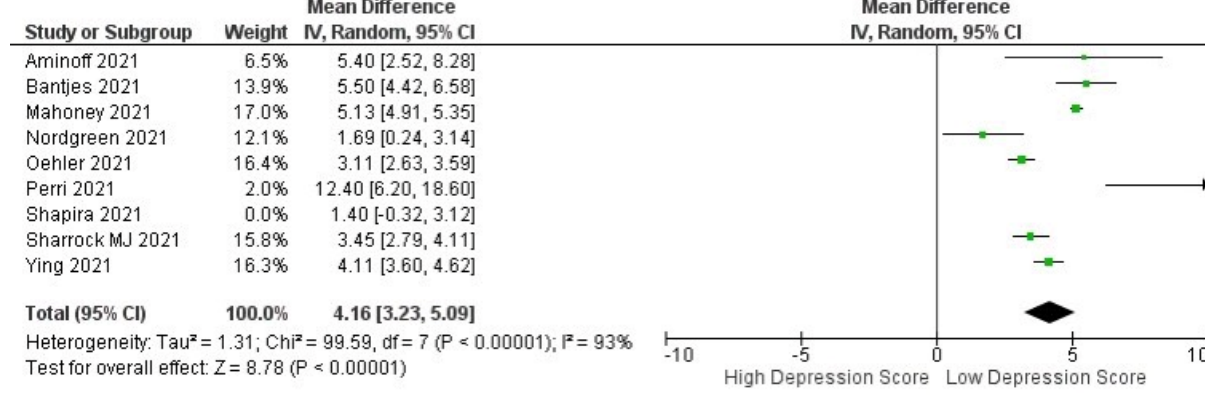
Figure 6. Sensitivity analysis for studies analyzing pre- and post- in depression score.